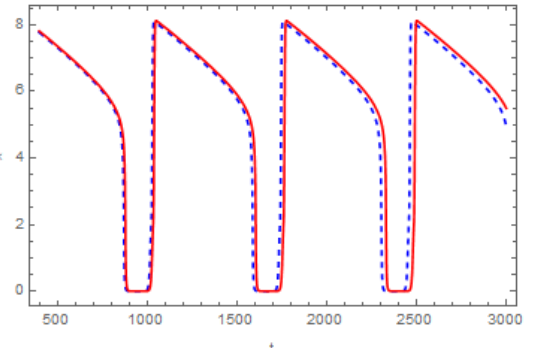
Figure 7. Time series for the relaxation oscillation of the prey with the blue dashed curve (System (5)) and the red full curve (System